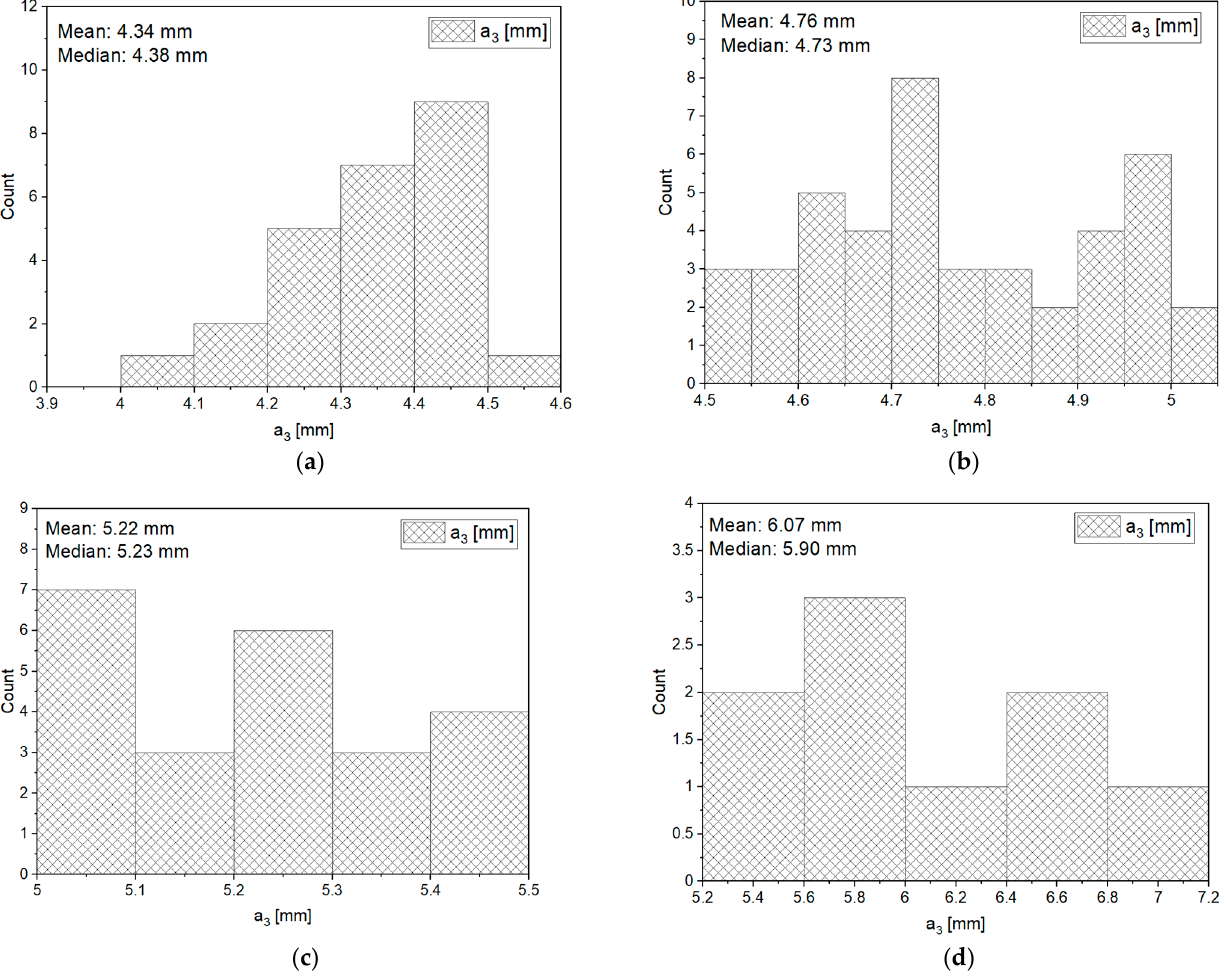
Figure 15. Distribution of particle sizes in the analyzed size intervals ( a ) distribution in the size range (4.0–4.5) mm, ( b ) distribution in the size range (4.5–5.0) mm, ( c ) distribution in the size range (5.0–5.5) mm, ( d ) distribution in the size range (>5.5) mm.